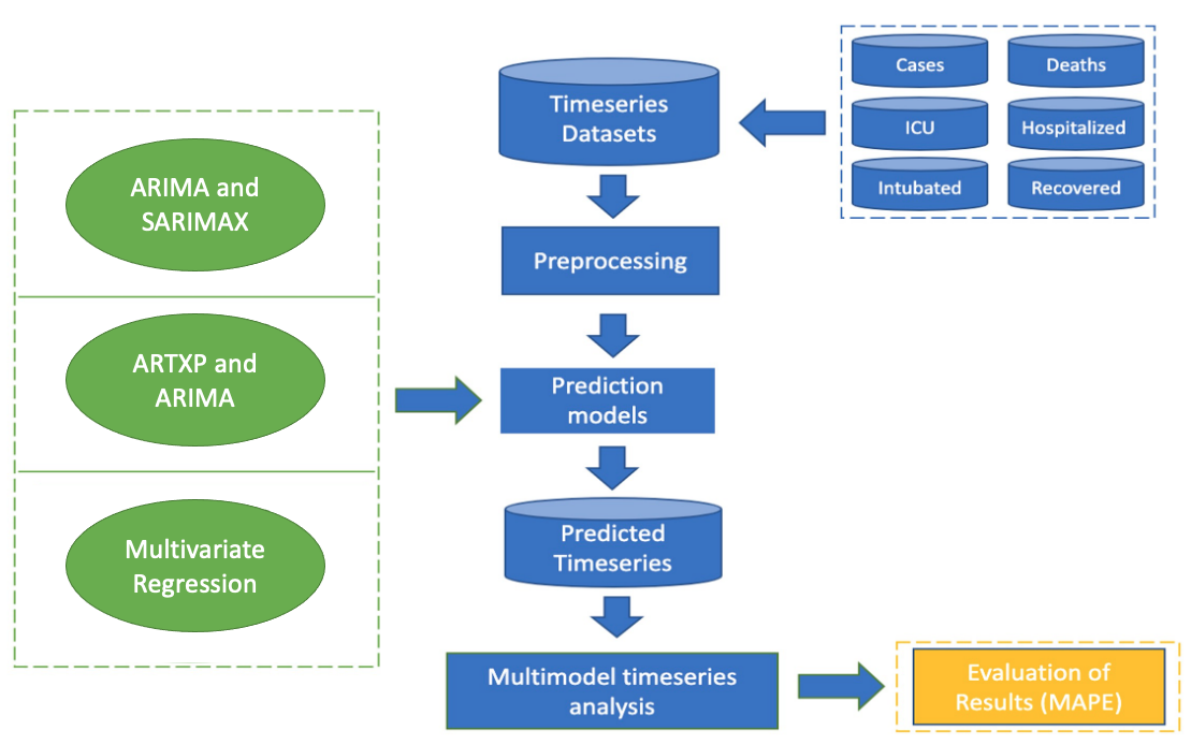
Figure 3. Research methodology flowchart for all predictive